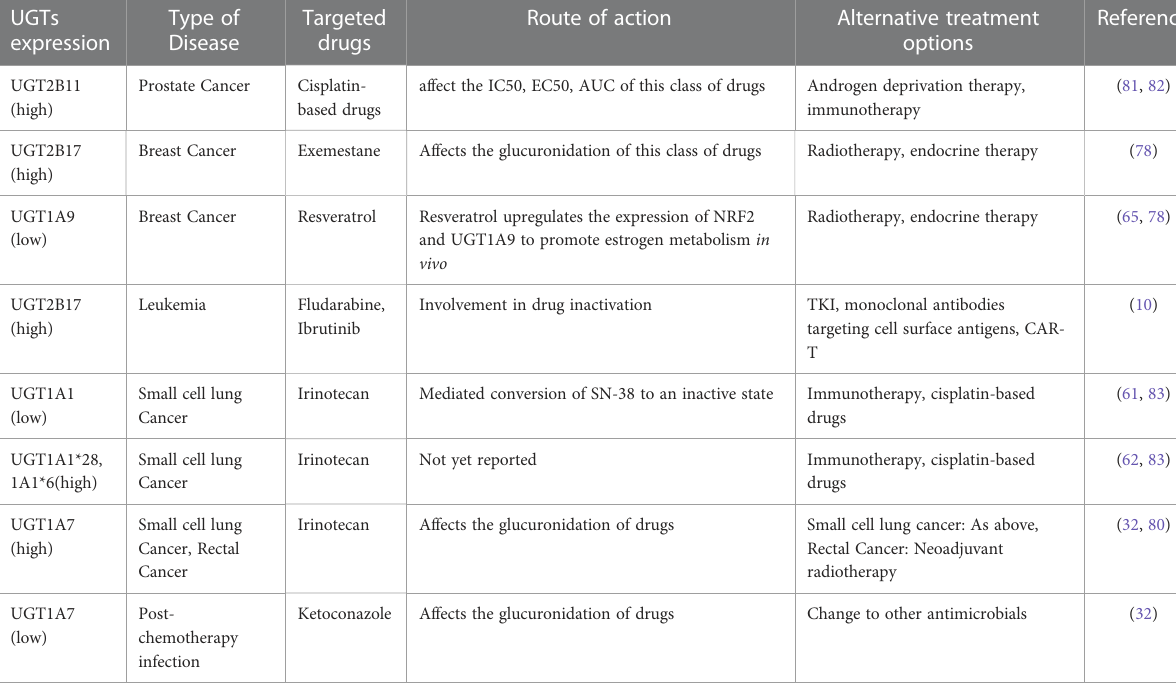
TABLE 2 Relationship between UGTs expression and adverse drug